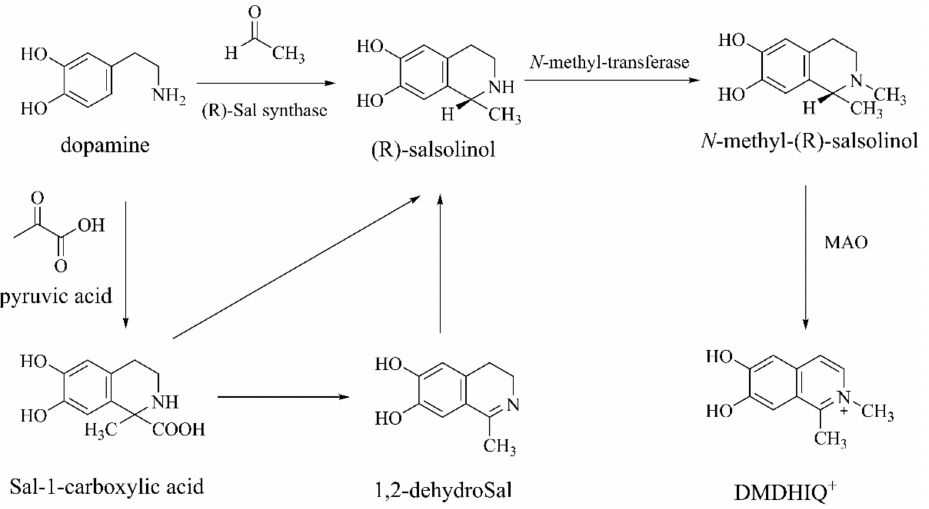
Figure 4. The biosynthesis and metabolism of (R)-salsolinol and N -methyl-(R)-salsolinol [45]. Sal inhibits the mitochondrial electron transport chain, inducing oxidative stress and mediating α -Synuclein to induce apoptosis. Villageliu and colleagues found that Escherichia coli produces Sal under an analogous intestinal environment containing DA, and adding alcohol raises the Sal content [46], suggesting that Sal might be generated by gut microbes, thus affecting neurological diseases. Although the neurotoxic effects of Sal have been extensively studied, the potential neuroprotective effects of low-dose Sal should not be overlooked. For example, previous findings show that [44] 10–250 µ M of Sal produce neuroprotective effects rather than cytotoxicity and could reduce ROS and caspase activity caused by H 2 O 2 or 6-OHDA. Furthermore, ( R )-Sal can be converted into N -methyl-( R )- salsolinol by N -methyl-transferase. N -methyl-( R )-salsolinol is an endogenous neurotoxin found in urine and in the cerebrospinal fluid of PD patients and it is more toxic than Sal [47]. N -methyl-( R )-salsolinol can activate caspase-3 and increase oxidative stress, leading to the apoptosis of SH-SYSY cells [48]. N -methyl-( R )-salsolinol is oxidized into 1,2-dimethyl-6,7- dihydroxy-1,2,3,4-tetrahydroisoquinolineion (DMDHIQ + ) by MAO [49] (Figure 4). Similar to MPP + , DMDHIQ + induces apoptosis through the inhibition of mitochondrial complex I and the increase in ROS [50]. At present, Sal and N -methyl-salsolinol are used to construct cellular models of PD, rather than animal